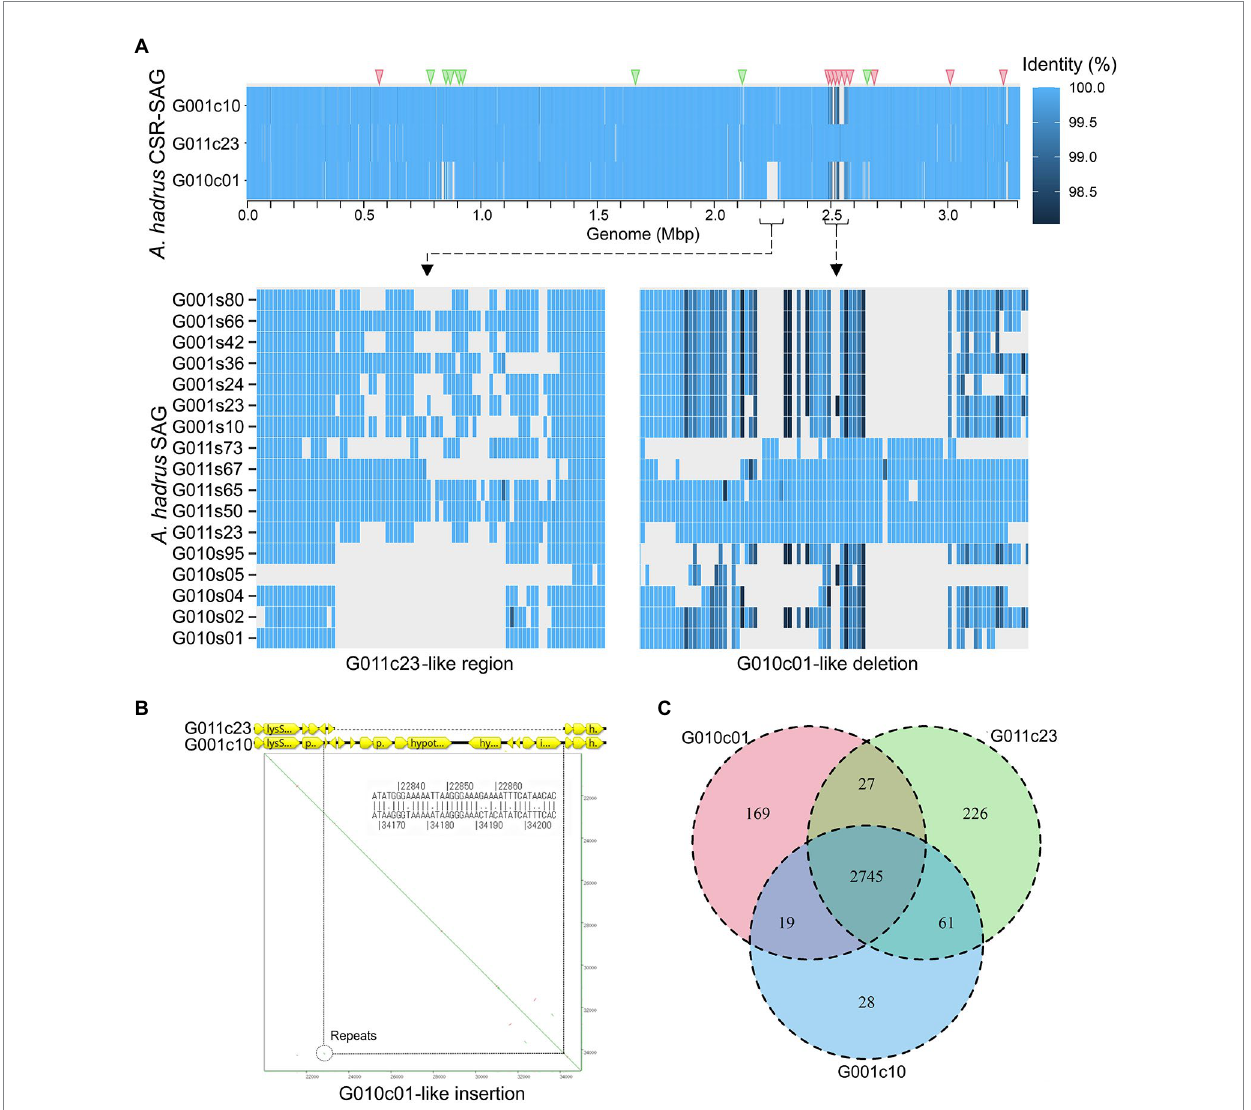
FIGURE 5 Inter-strain genome structure variation in A. hadrus strain SAGs obtained from the same host or a cohabitant at different time points. (A) Heatmap showing nucleotide identity of each strain CSR-SAG with the circular single-amplified genomes (cSAGs) of A. hadrus G01c23. G011c23, and G001c10 derived from the same host, whereas strain G010c01 was derived from the cohabitant. Triangles at the top of the heatmap indicate SNPs detected upon comparing the three A. hadrus strains (red: G001c10-G010c01 common nucleotides, green: G001c10-G011c23 common nucleotides). Detailed view shows raw SR-SAG mapping results, indicating G010c01-like deletion in the G001c10 genome compared with the G011c23 genome. (B) Gene map and dot plot of G010c01-like insertion region in the G001c10 genome compared with the G011c23 genome. (C) Venn diagram of homologous gene clusters in genomes of the three A. hadrus